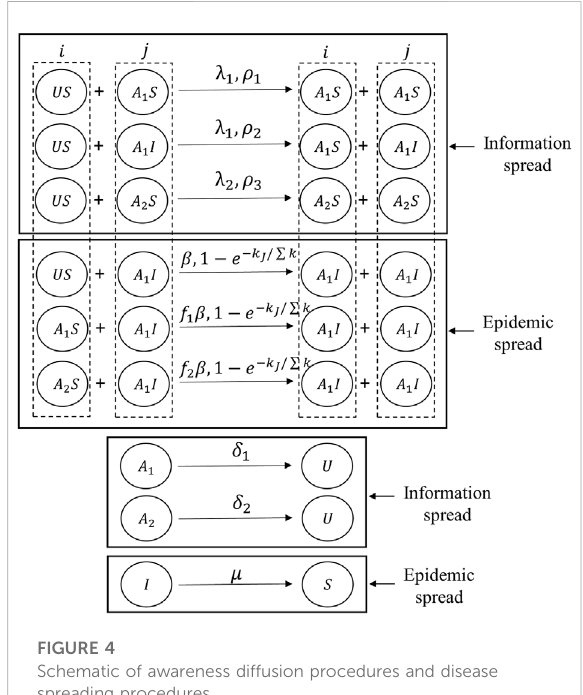
FIGURE 4 Schematic of awareness diffusion procedures and disease spreading